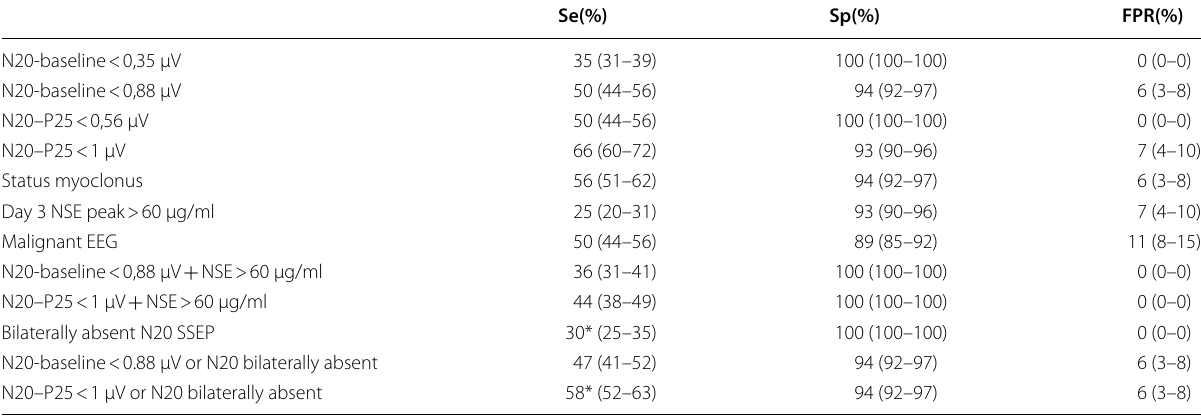
Table 4 Accuracy of the SSEP and EEG malignant patterns, status myoclonus, NSE > 60 µg/ml and combinations for prediction of poor outcome